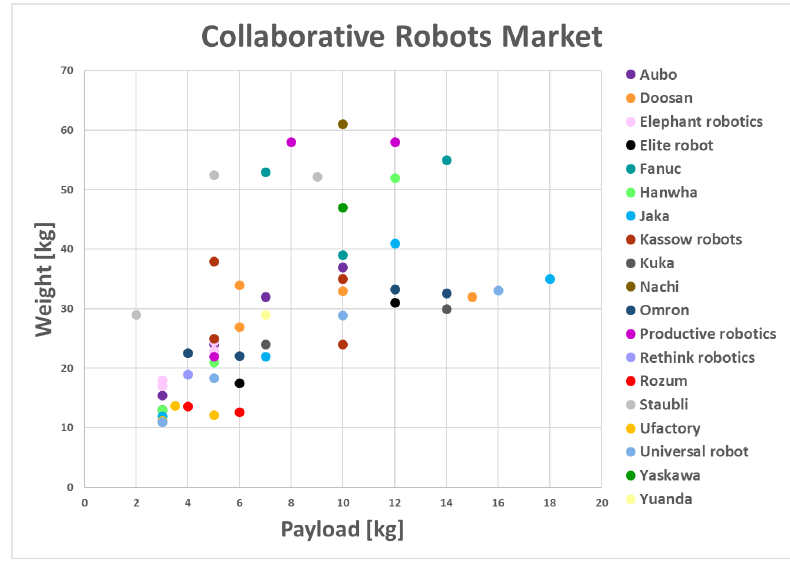
Figure 1. Collaborative Robots Market: weight vs.